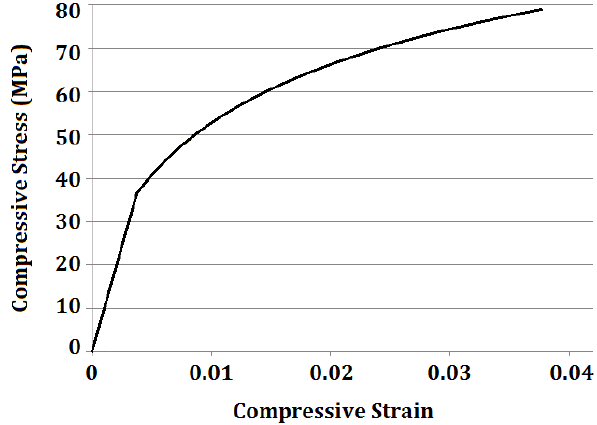
Figure 6. Mesh refinement study results: the optimum element size and stress.